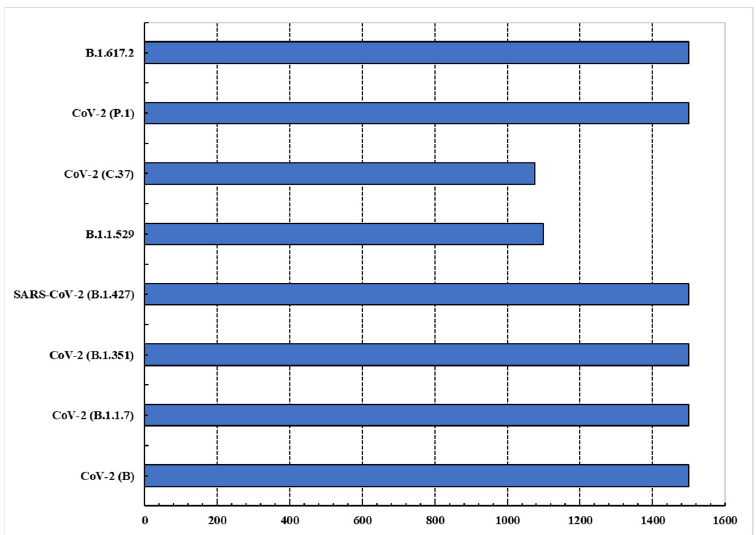
Figure 3. Details of data collected for each COVID-19 variant; x -axis shows number of sequences for each variant described on the y -axis.